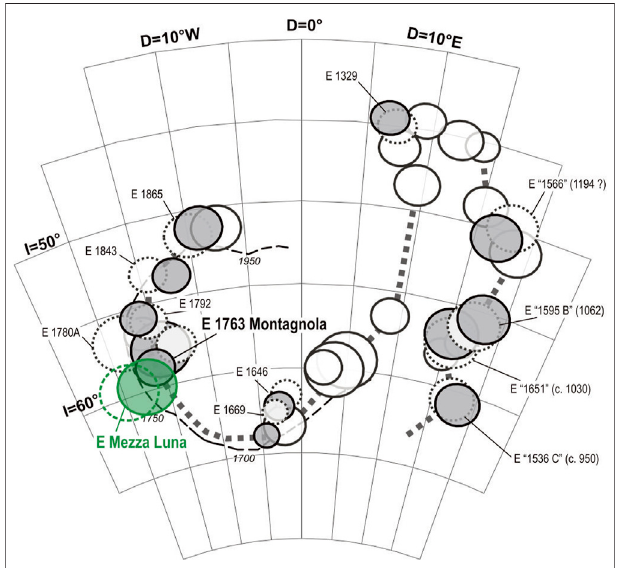
FIGURE 4 | Position of Mt, Mezza Luna in the archeomagnetic curve of Etna historical lavas (modi fi ed from Le Goff and Tanguy, 2004). The Alpha 95 con fi dencecirclesofthepaleomagneticdirectionsbefore(dashedcircles)and after correction for local disturbances of the Earth magnetic fi eld (shadowed circles) are reported for the various sites. Mt. Mezza Luna fl ow (shadowed green circle) partly overlaps the 1763 eruption of La Montagnola.